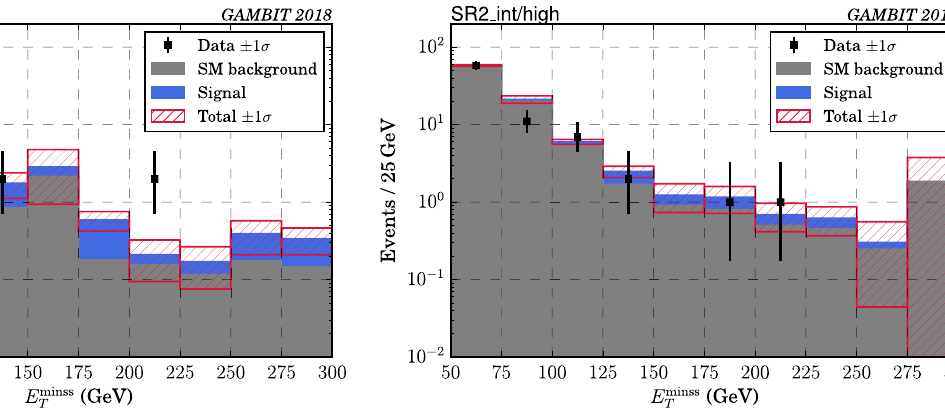
tainty on the total number of expected events, found by summing in quadrature the background uncertainty and the signal statistical uncer- tainty for our best-fit point. The black points show the ATLAS data